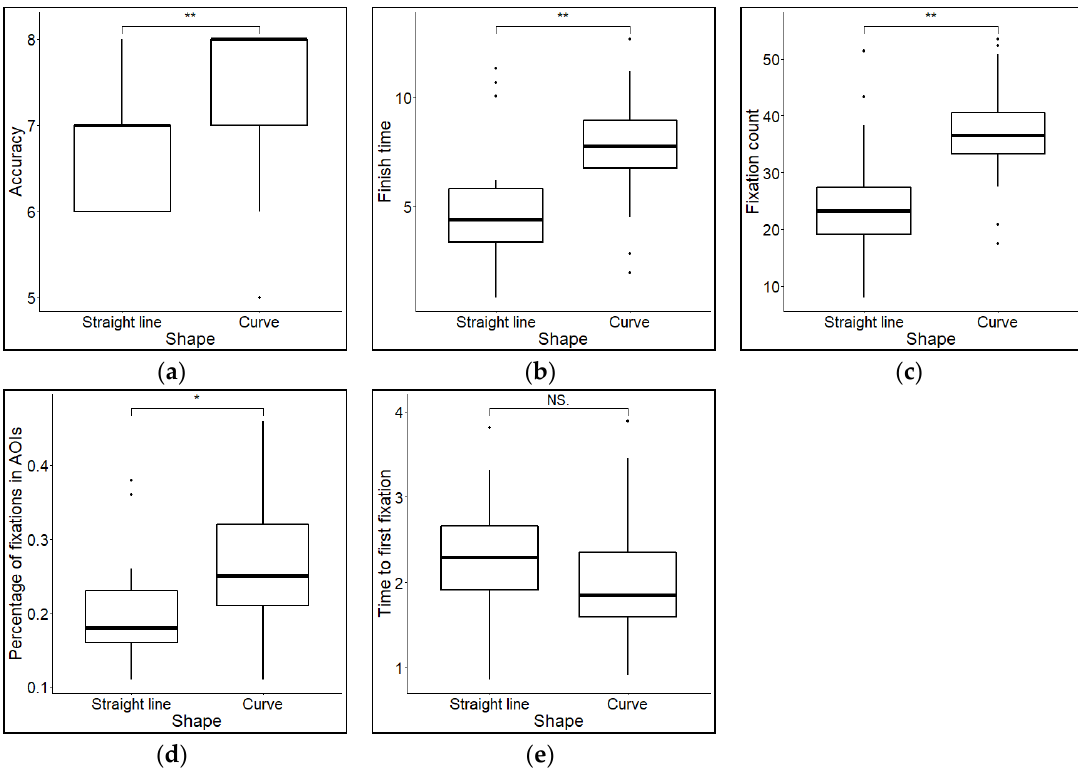
Figure 3. Statistics for the different line shapes and Mann-Whitney U test results ( * p < 0.05, ** p < 0.01 and NS. = not significant). ( a ) Accuracy; ( b ) finish time; ( c ) fixation count; ( d ) percentage of fixations in AOIs; and ( e ) time to first fixation.